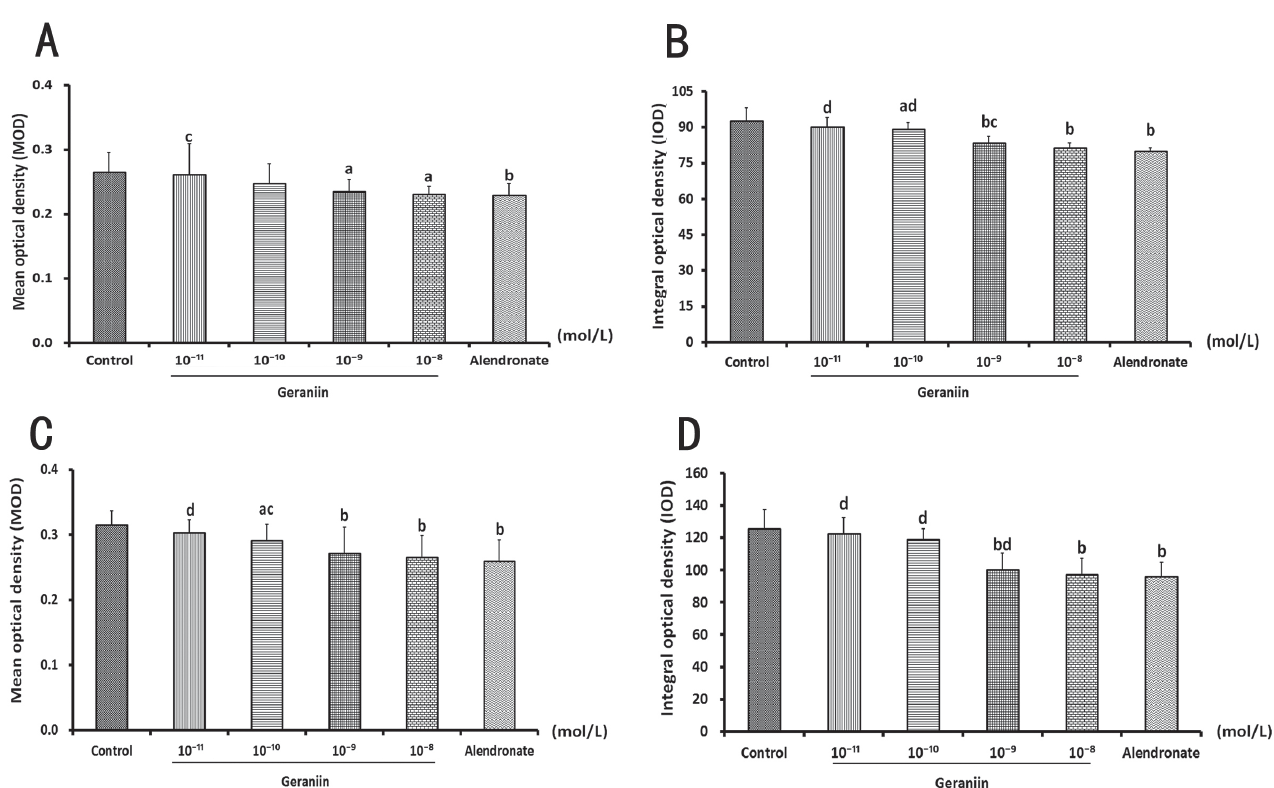
FIGURE 7 - Effect of geraniin on protein and mRNA expression of RANKL in osteoblasts. Geraniin (10 -11 to 10 -8 mol/L) concentration-dependently decreased IOD (A) and MOD (B) values of RANKL protein expression in positive cells. Geraniin (10 -11 to 10 -8 mol/L) concentration-dependently decreased MOD (C) and IOD (D) values of RANKL mRNA expression in positive cells. a P < 0.05, b P < 0.01 versus control group, c P < 0.05, d P < 0.01 versus alendronate group, e P < 0.05 versus between geraniin (10 -11 to10 -8 mol/L) groups. One-way ANOVA followed by Student’s t